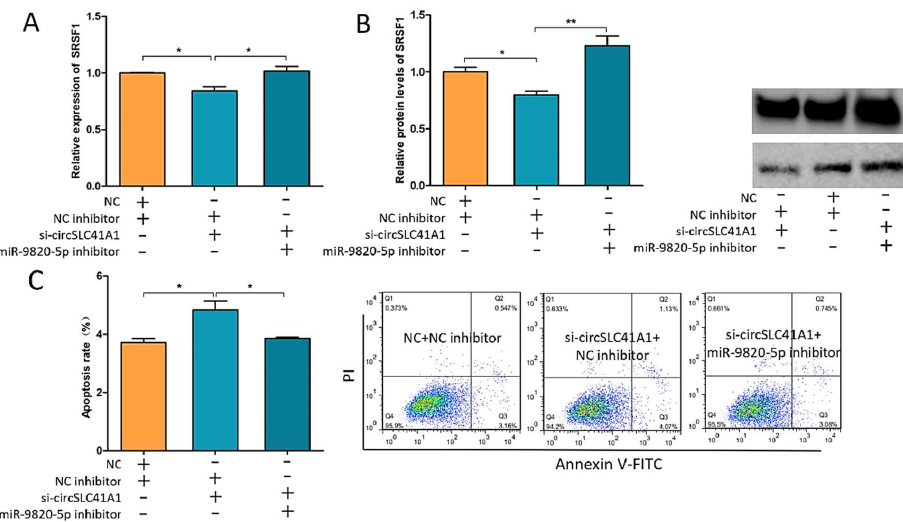
Figure 6. circSLC41A1 inhibits GCs apoptosis by upregulating SRSF1 through sponging miR−9820−5p. ( A ) The shift of SRSF1 mRNA levels after co−transfection of si−circSLC41A1 and miR−9820−5p inhibitors detected by qRT−PCR. ( B ) The shift of SRSF1 protein levels after co−transfection of the si−circSLC41A1 and miR−9820−5p inhibitors detected by WB. ( C ) Change of GC apoptosis rates after co−transfection of si−circSLC41A1 and miR−9820−5p inhibitors detected by flow cytometry. Data are expressed as the mean ± SEM of three experiments; * p < 0.05, ** p < 0.01.